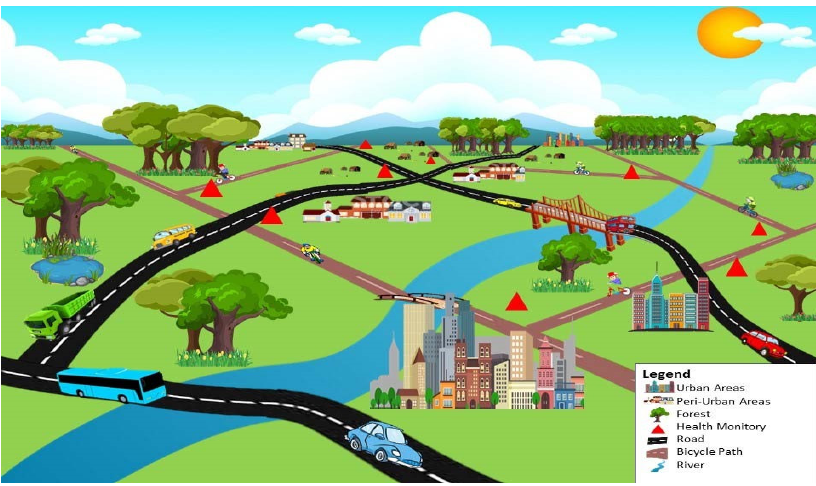
Figure 2. An integrated mobility and transport system. Source: Authors.